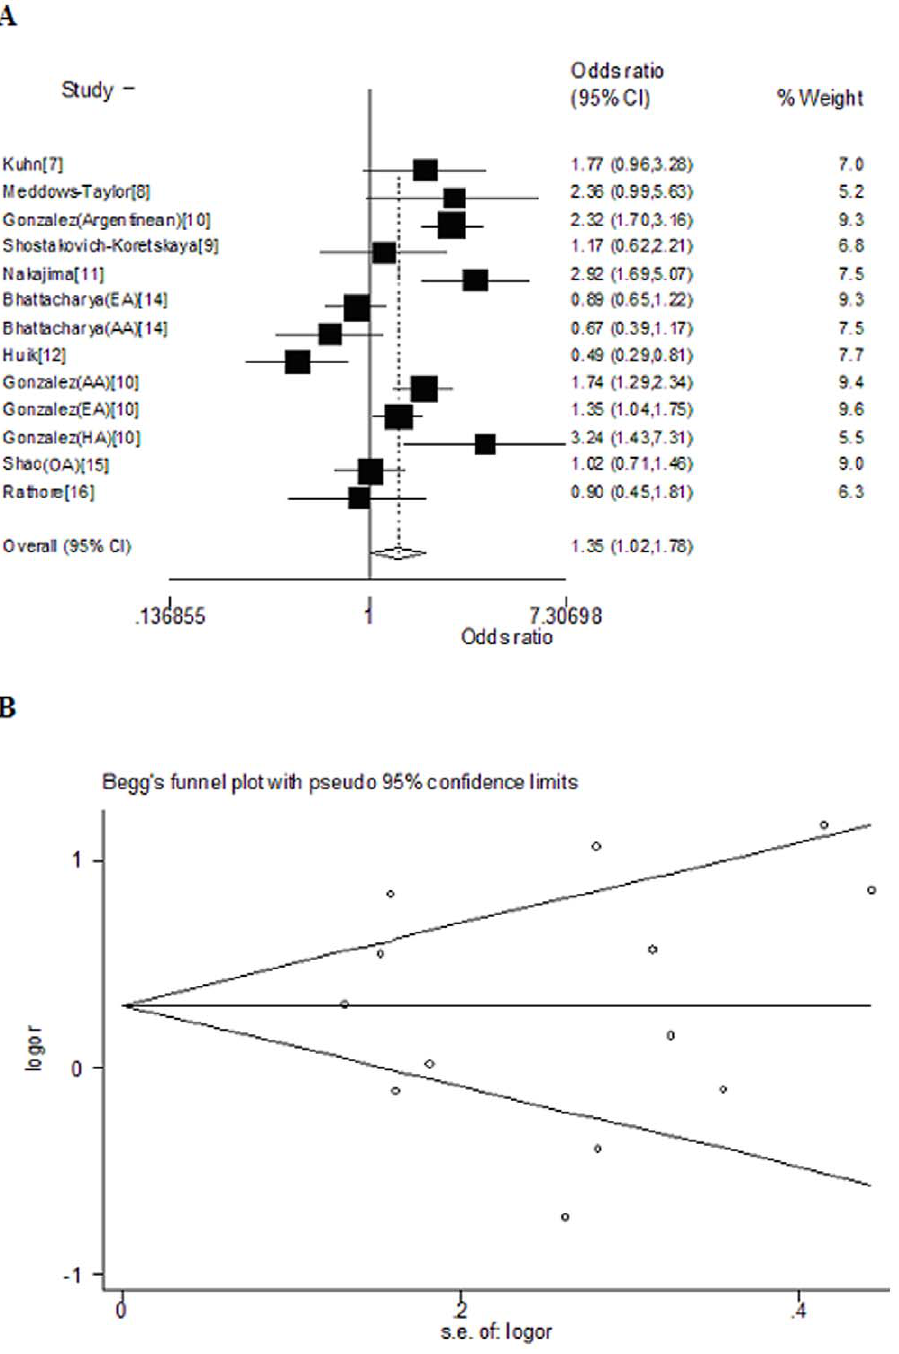
Figure 2. By using the GCN # PMN Vs. GCN . PMN model, (a) forest plot of overall analysis; (b) funnel plot to detect publication bias in overall analysis. Data of studies involving mixed race was set apart according to different ethnicity. AA, African American; EA, European American; HA, Hispanic American; OA, Other American except African American.